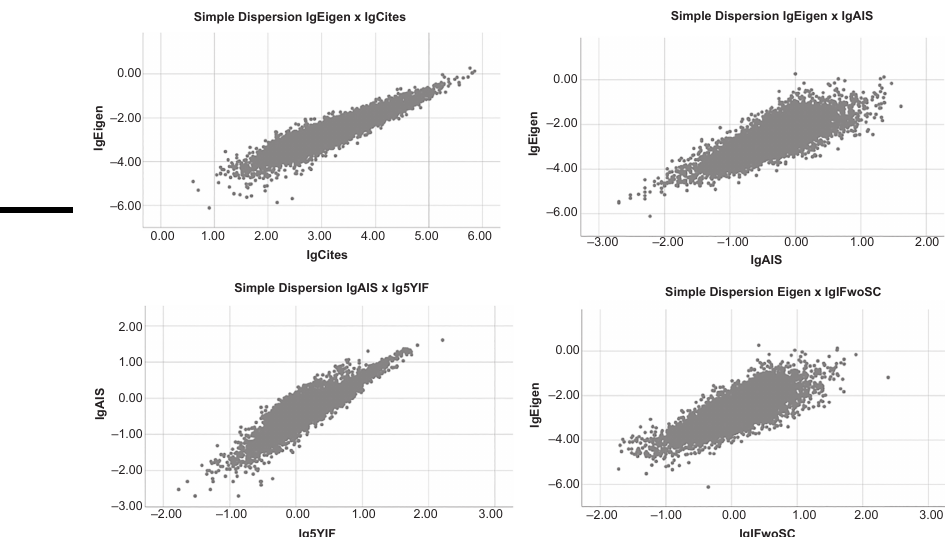
Figure 2. Dispersion graphs showing high correlations between logarithms of eigenvalue scores and cites; eigenvalues and AIS sores; AIS scores and 5YIF scores, and eigenfactor scores and IF scores without self-citations. Source: Own elaboration.